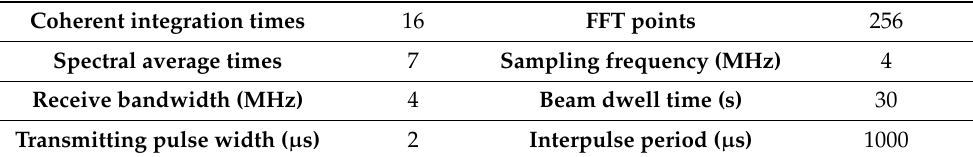
Table 2. Signal processing parameter configuration.